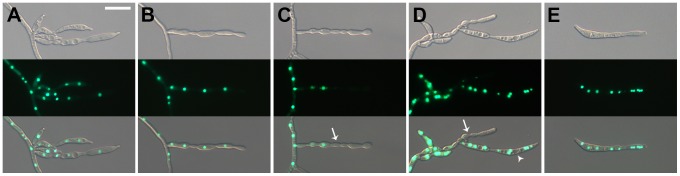
Morphology of conidiophores of AbaA-OE strains.Pictures were taken 1 to 3 days after conidium induction from carboxymethyl cellulose (CMC) medium. Multiple phialides were produced from a single hyphal compartment (A). Some phialides resembled abacus-like structures, and some cells near the end did not contain detectable nuclei (B–D). (E) Conidia produced from AbaA-OE strains (E). Cells that did not contain detectable nuclei and mature conidia resembling abacus-like structures are indicated by white arrows and arrow heads, respectively. Scale bar = 20 µm.